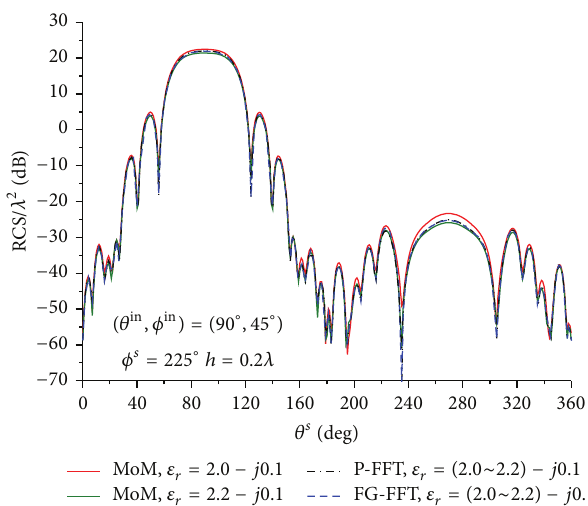
Figure 9: Bistatic RCS curves of the inhomogeneous dielectric slab ( ℎ = 0.2𝜆 ) in Example